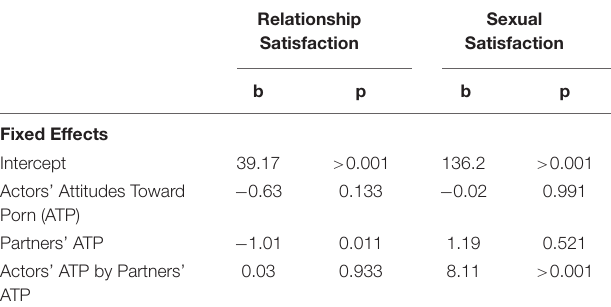
TABLE 4 | Linear mixed models predicting relationship and sexual satisfaction for Study 2 ( N = 77